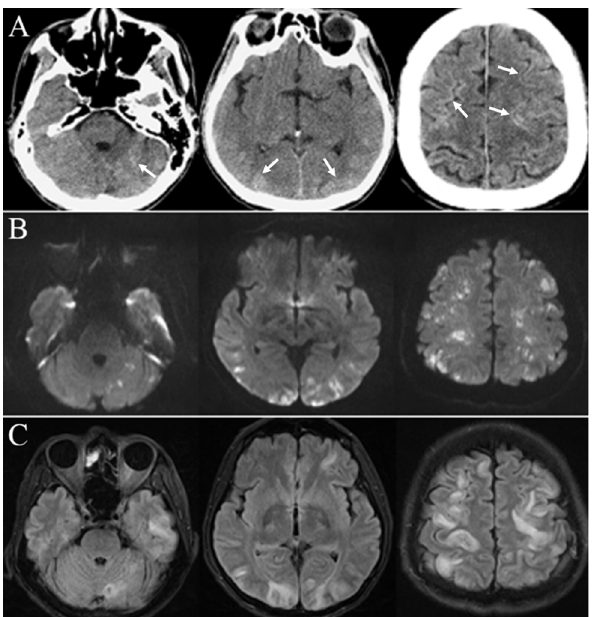
Fig 1. Head imaging findings in a patient with hepatocellular carcinoma who had cerebral lipiodol embolism (CLE) after transarterial chemoemobolization. Head CT and MRI were performed at 9 hours and 1 day after the symptoms, respectively. Row A: Head non-contrast CT showed disseminated high- density lesions mainly at gray matter (arrow), Row B and C: diffusion weighted imaging (DWI) and T2 fluid attenuation inversion recovery (FLAIR) of head MRI. The scans showed multiple disseminated hyperintensity/high signal lesions mainly at the gray matter of the cerebrum and cerebellum. The larger areas on FLAIR than on DWI for the same lesions indicate the existence of peri-stroke edema.